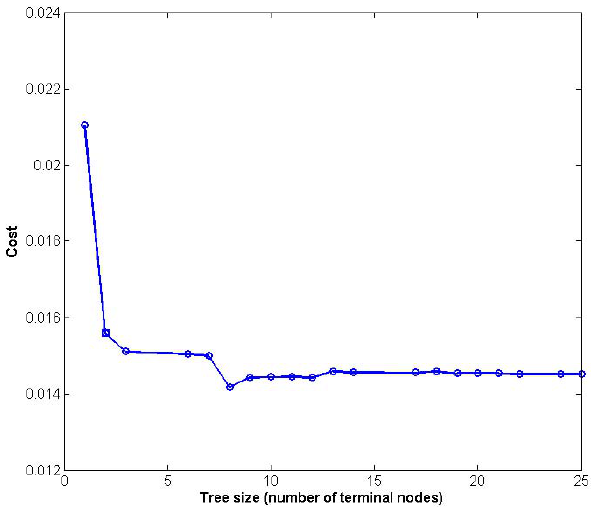
Fig. 4. Cost function of regression tree RT1.